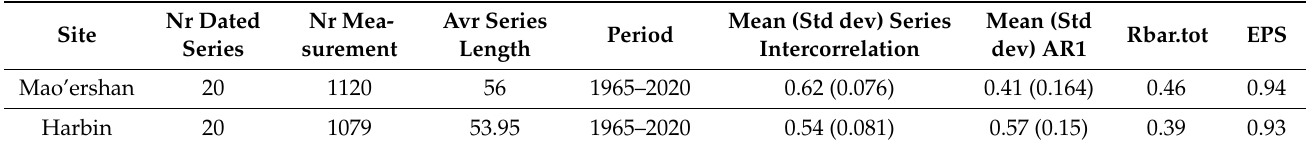
Table 1. Characteristics of the tree ring width chronology of Q. mongolica from Mao’ershan and Harbin sites. EPS = Expressed Population